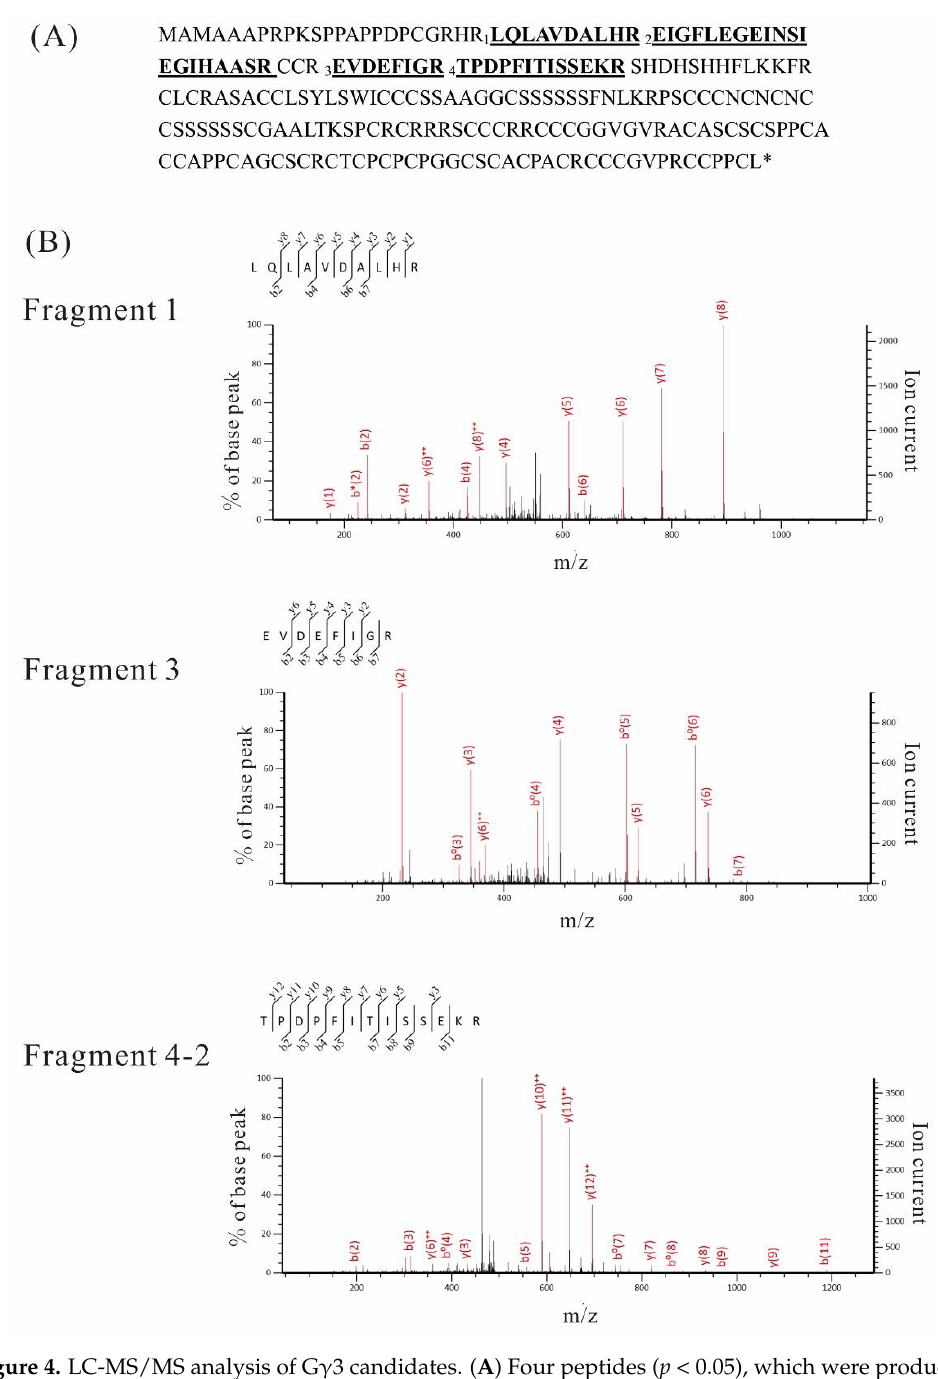
Figure 4. LC-MS/MS analysis of Gγ3 candidates. ( A ) Four peptides ( p < 0.05), which were